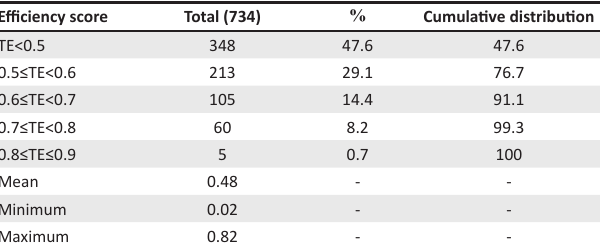
TABLE 3: Frequency distribution of technical efficiency